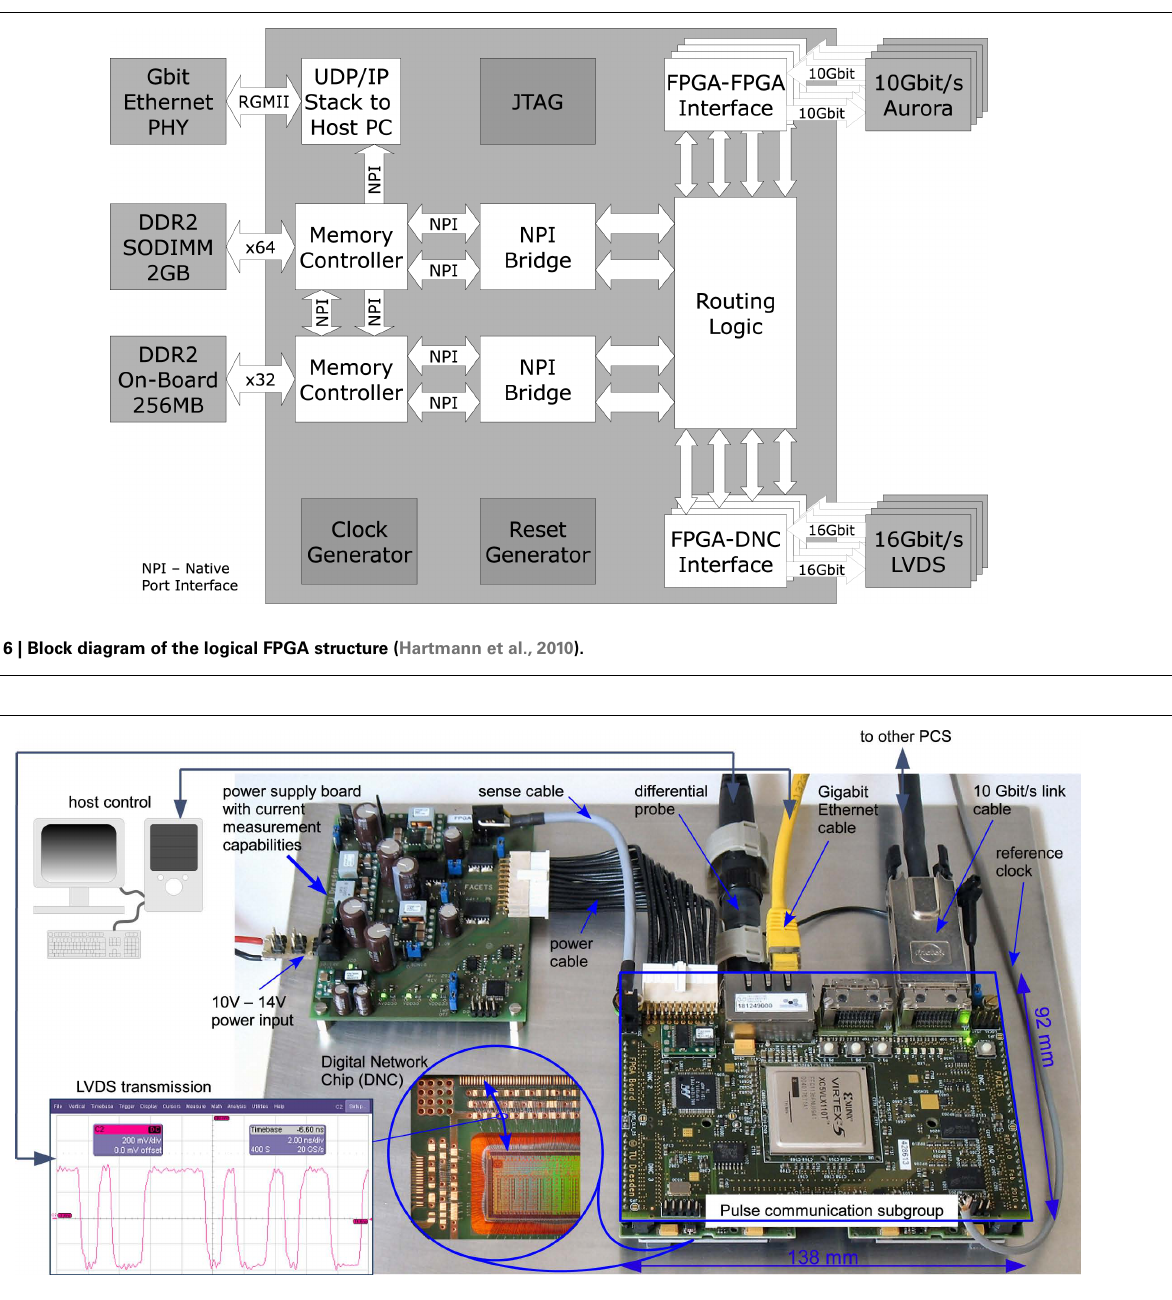
FIGURE 7 | Photograph of the PCS in its measurement setup. Compared to the PCS in Figure 1 , the heat pipes and heat sink have been removed for better visibility.